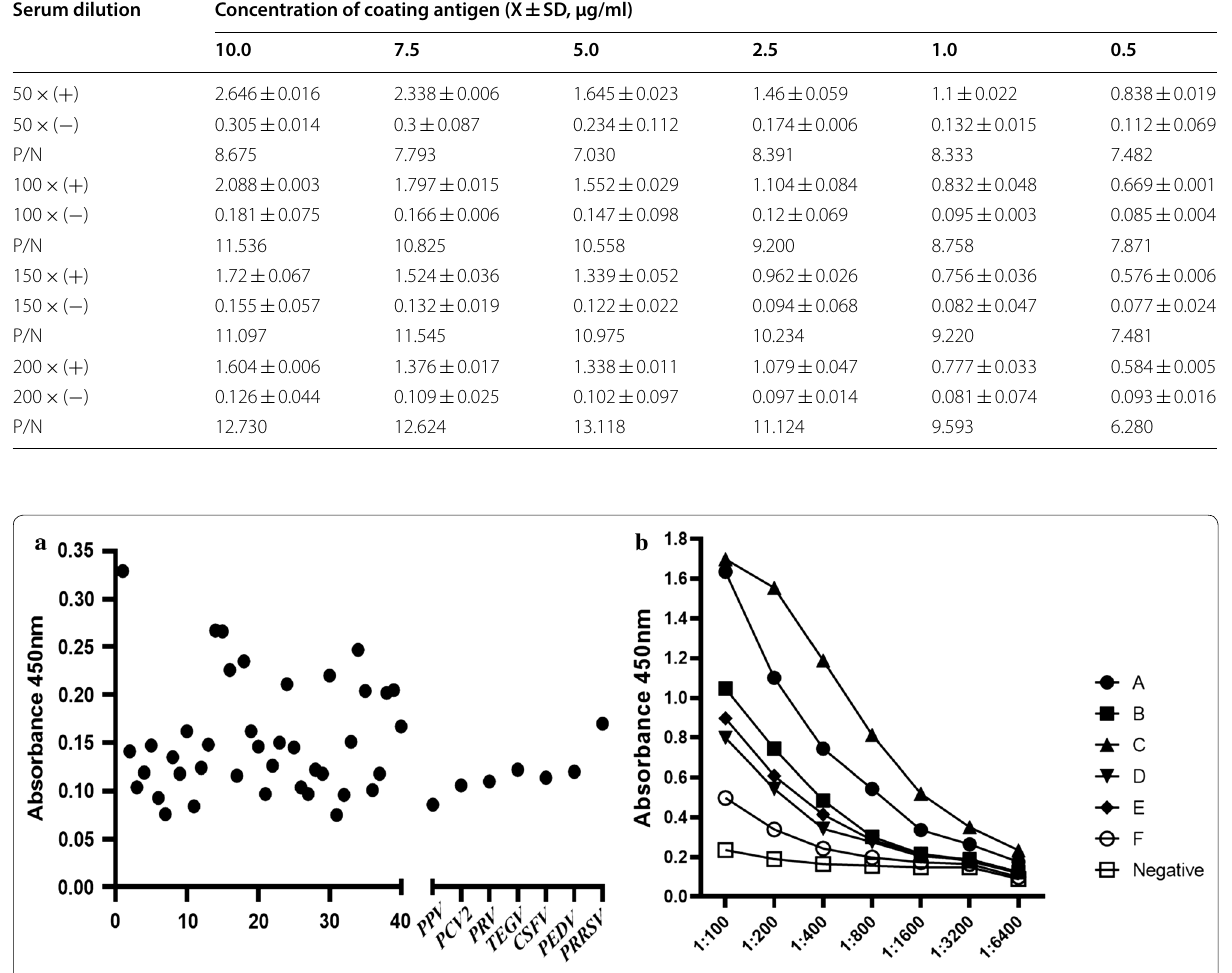
Table 1 Optimal dilutions for antibody and coating antigen for VLP-based I-ELISA Serum dilution